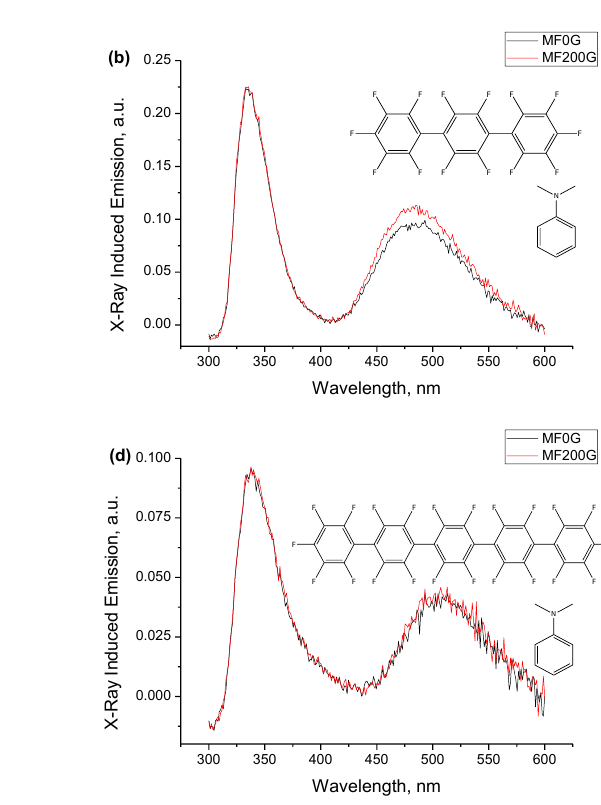
Figure 5. Spectra of X-ray-induced luminescence for the mixtures of the four compounds ( a — 1 , b — 2 , c — 3 , d — 4 ) with DMA in n -dodecane solutions with an applied magnetic field. Sample compositions are identical to those used in Figure 3. Each panel shows two spectra from the degassed solution taken by field cycling at each point of the wavelength scan: without the magnetic field (black curve) and in the applied field of 200 G (red curve). Magnetic field effects obtained by the integration over the suitable spectral ranges are collected in Table 2. A DMA concentration of 10 −2 M in all samples, concentrations of compounds: 5 × 10 −3 M for 1 , 1.8 × 10 −3 M for 2 , 4.4 × 10 −4 M for 3 , 1.1 × 10 −4 M for 4 . Table 2. Magnetic field effect on local emission/exciplex emission bands. Integration Area (200 Compound Area (0 Gauss) b Range, nm a Gauss) c